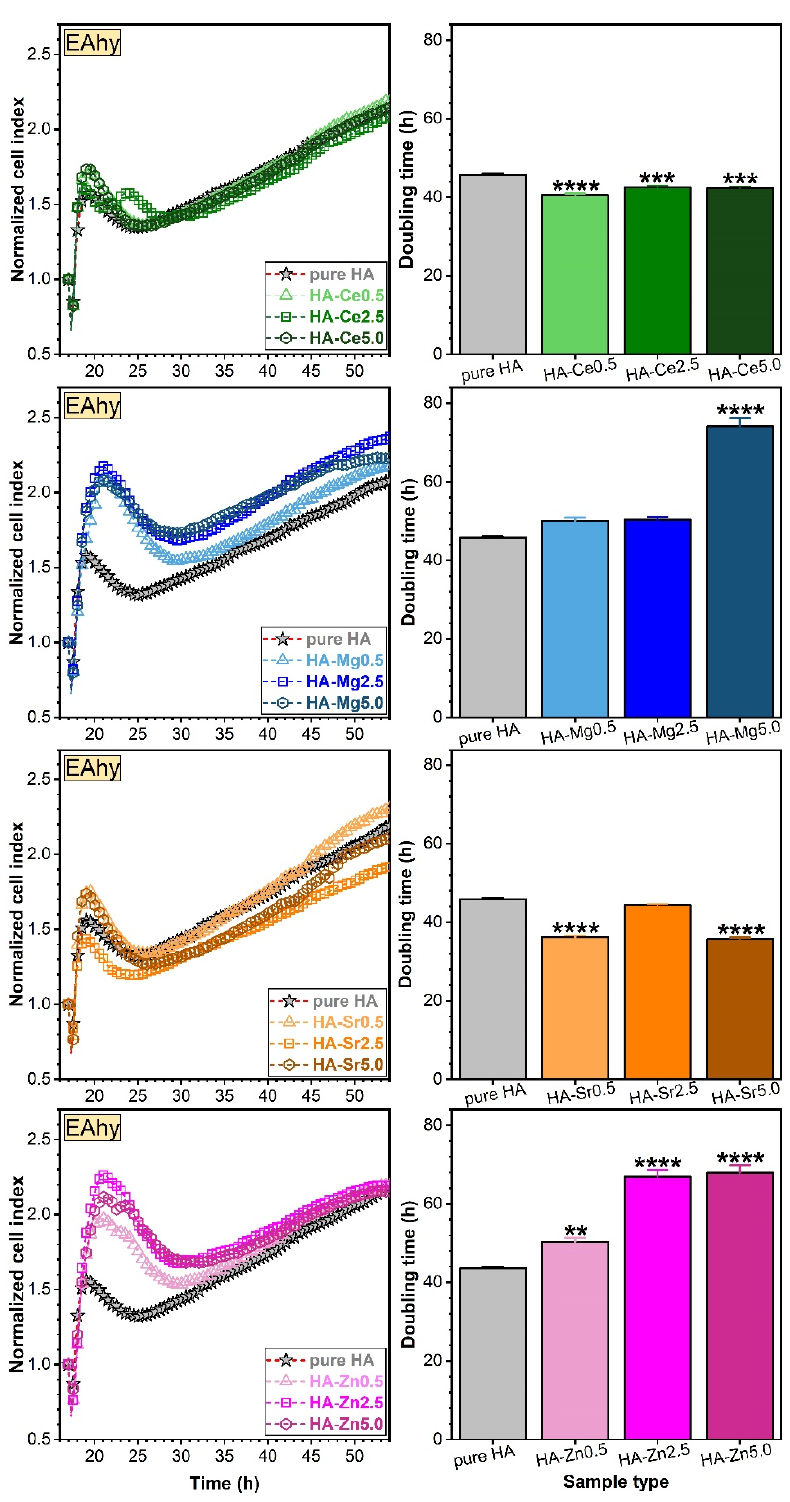
Figure 15. Impedance changes of the RTCA system mirroring the proliferation of EAhy cells in the presence of pure HA and Ce-, Mg-, Sr-, or Zn-substituted HA ( left panel ). The error bars were not figured as they would have obstructed the good visualisation of the evolution of mean values. The values of the doubling time were plotted as bars ( right panel ). ** p < 0.01, *** p < 0.001, and **** p < 0.0001 statistically significant differences with respect to pure HA (taken as control), as determined by using a one-way ANOVA multiple analysis followed by a Dunnett’s post hoc test.